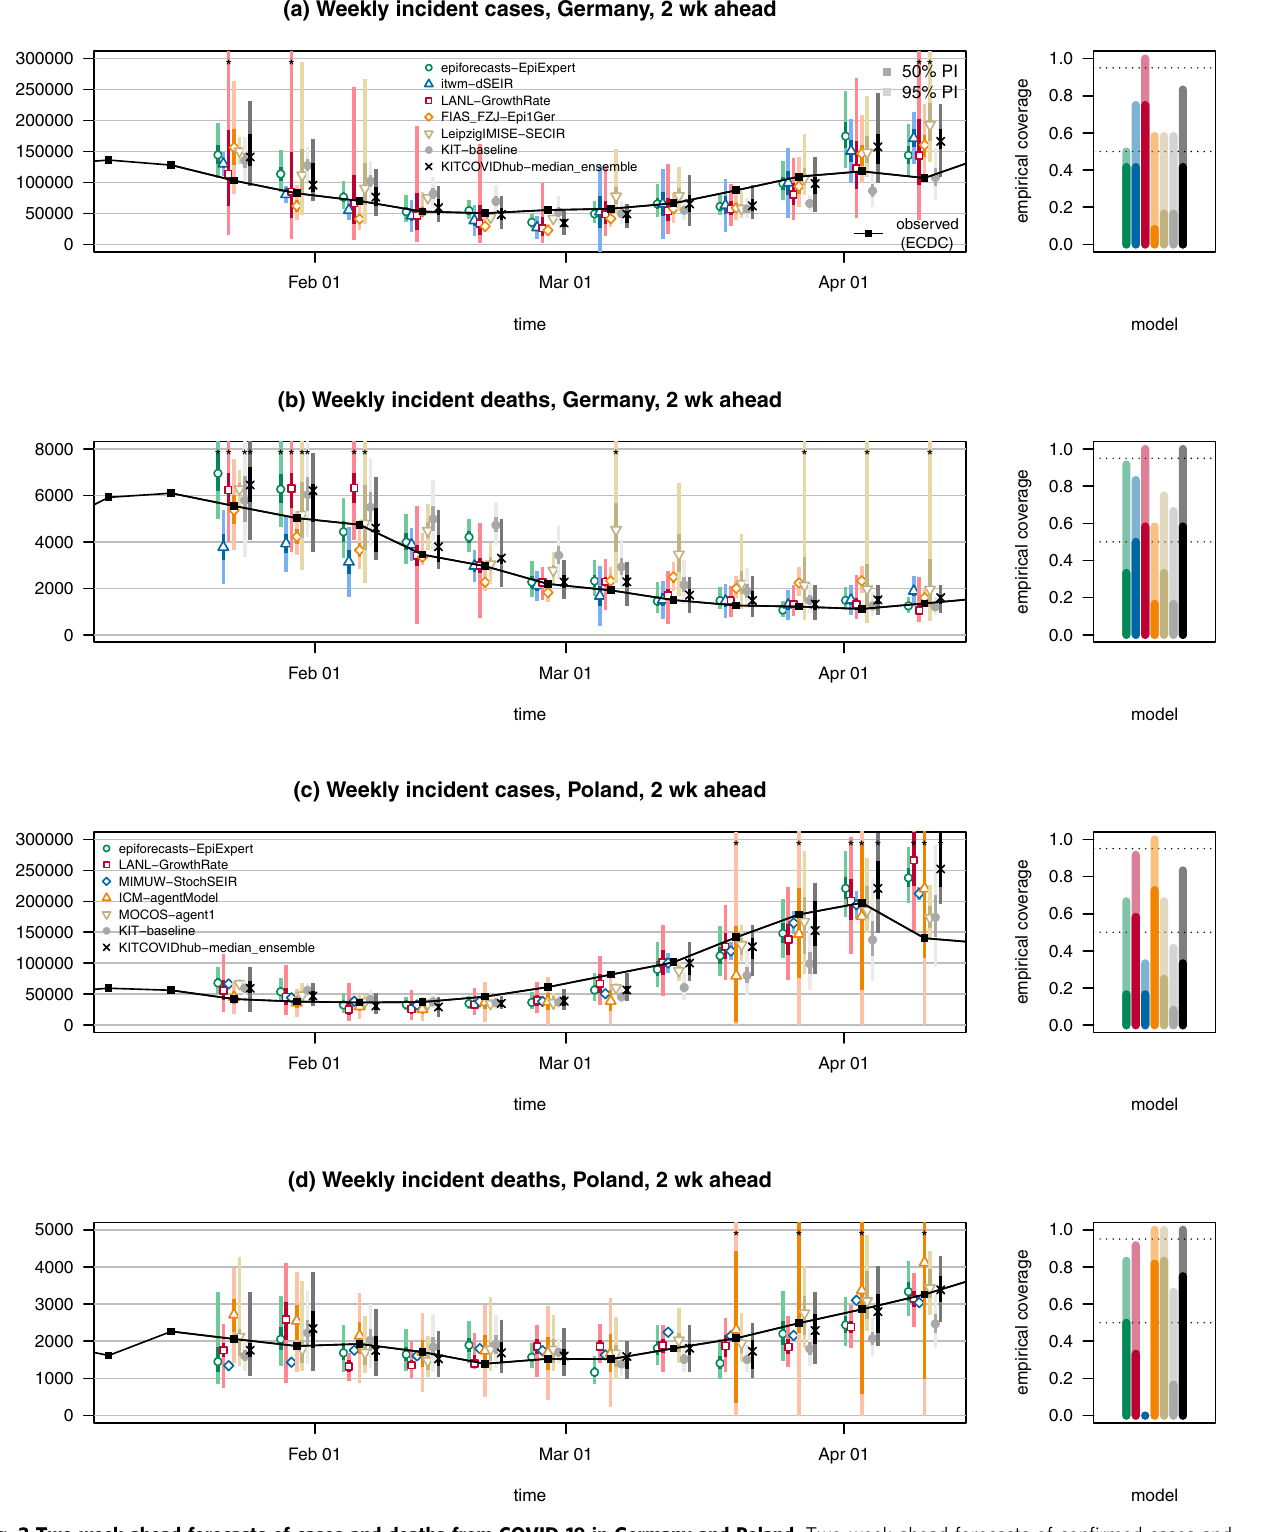
Fig. 3 Two-week-ahead forecasts of cases and deaths from COVID-19 in Germany and Poland. Two-week-ahead forecasts of con fi rmed cases and deaths from COVID-19 in Germany ( a , b ) and Poland ( c , d ). It shows forecasts from a baseline model, the median ensemble of all submissions, and a subset of submitted models. The remaining submitted models are displayed in Supplementary Fig. 2. The black line shows observed data. Colored points represent predictive medians, and dark and light bars show 50 and 95% prediction intervals, respectively. The right column shows the empirical coverage rates of the different models. See the caption of Fig. 2 for a detailed explanation of plot